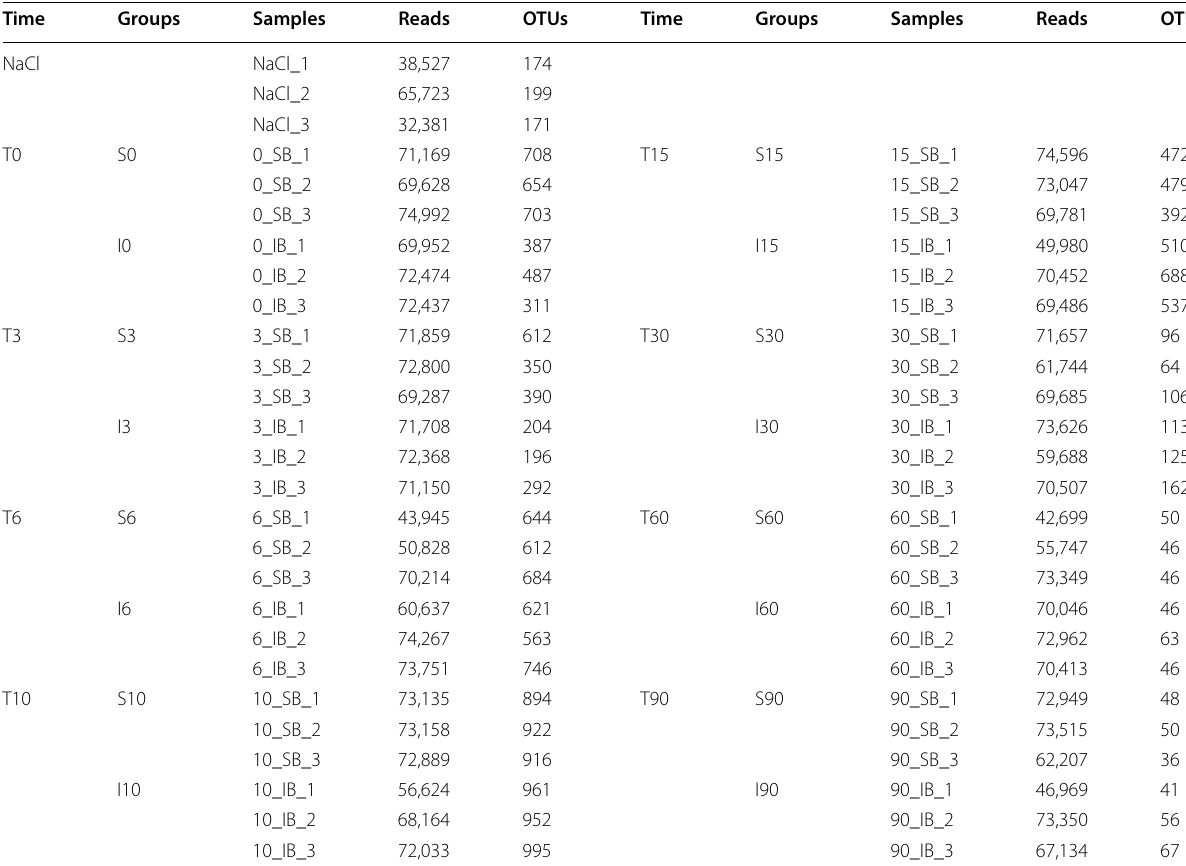
Table 1 Sequencing data of microbial samples of wet-salted goatskin at different time points